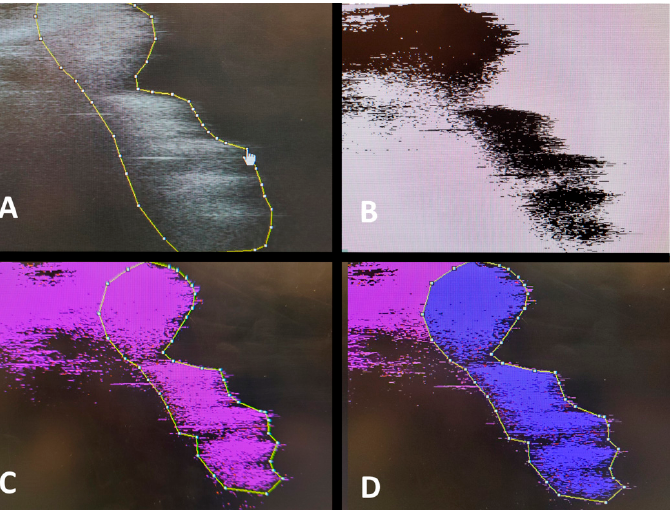
Figure 4. Image of processing for measuring. ( A ) Implant bed wall region of interest marked with a polygon. ( B ) Transformation in an 8-bit image. ( C ) Thresholding of the region of the interest based on the pixel color. ( D ) Region of interest structured and measured.